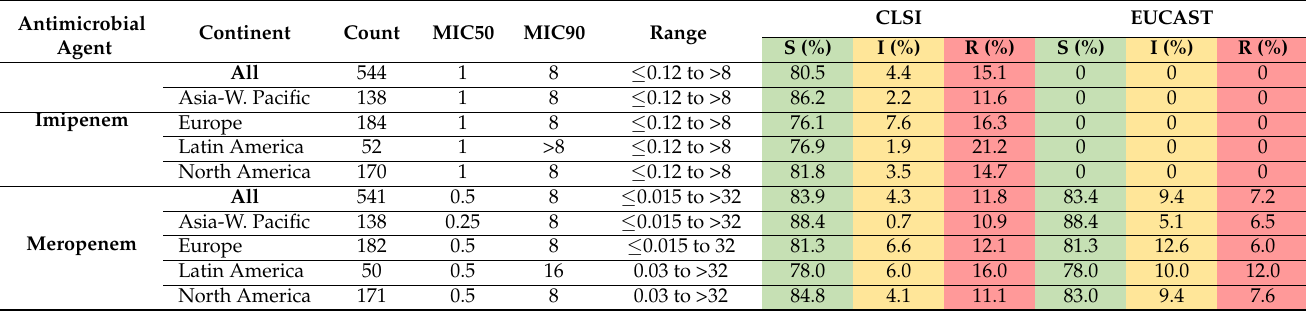
Table 6. Activity of antimicrobial agents tested against 545 Pseudomonas isolates from intra- abdominal